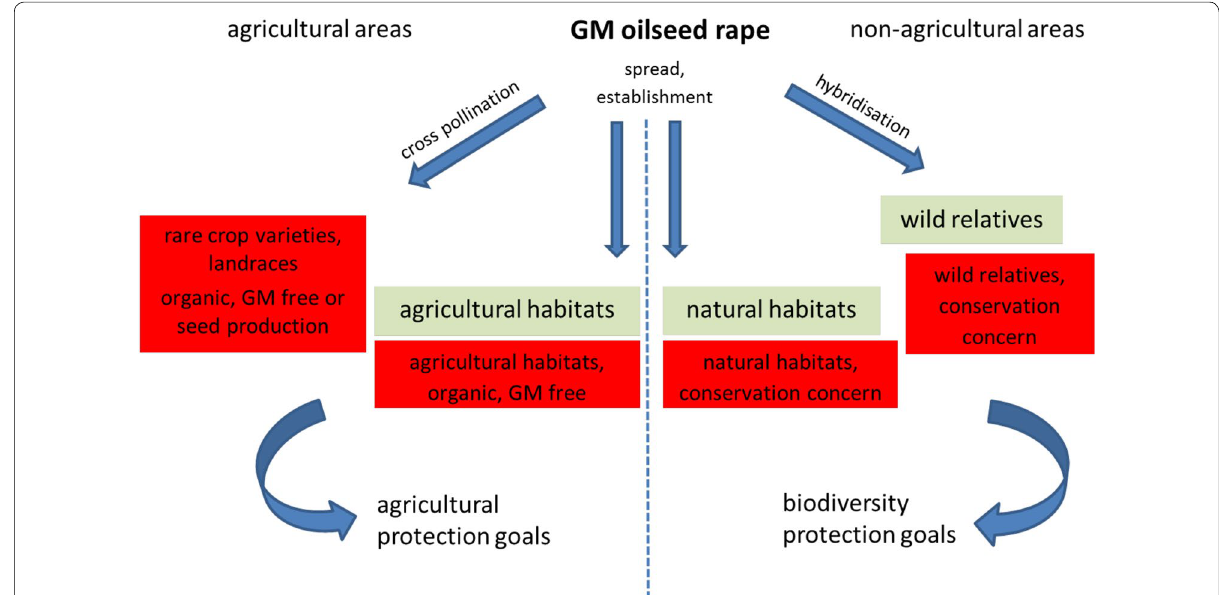
Fig. 2 Acceptability of natural processes due to GM oilseed rape cultivation in agricultural and non-agricultural areas. The natural processes are cross-pollination, spread and establishment and hybridisation. Red boxes processes may represent unacceptable impacts. Green boxes represent acceptable